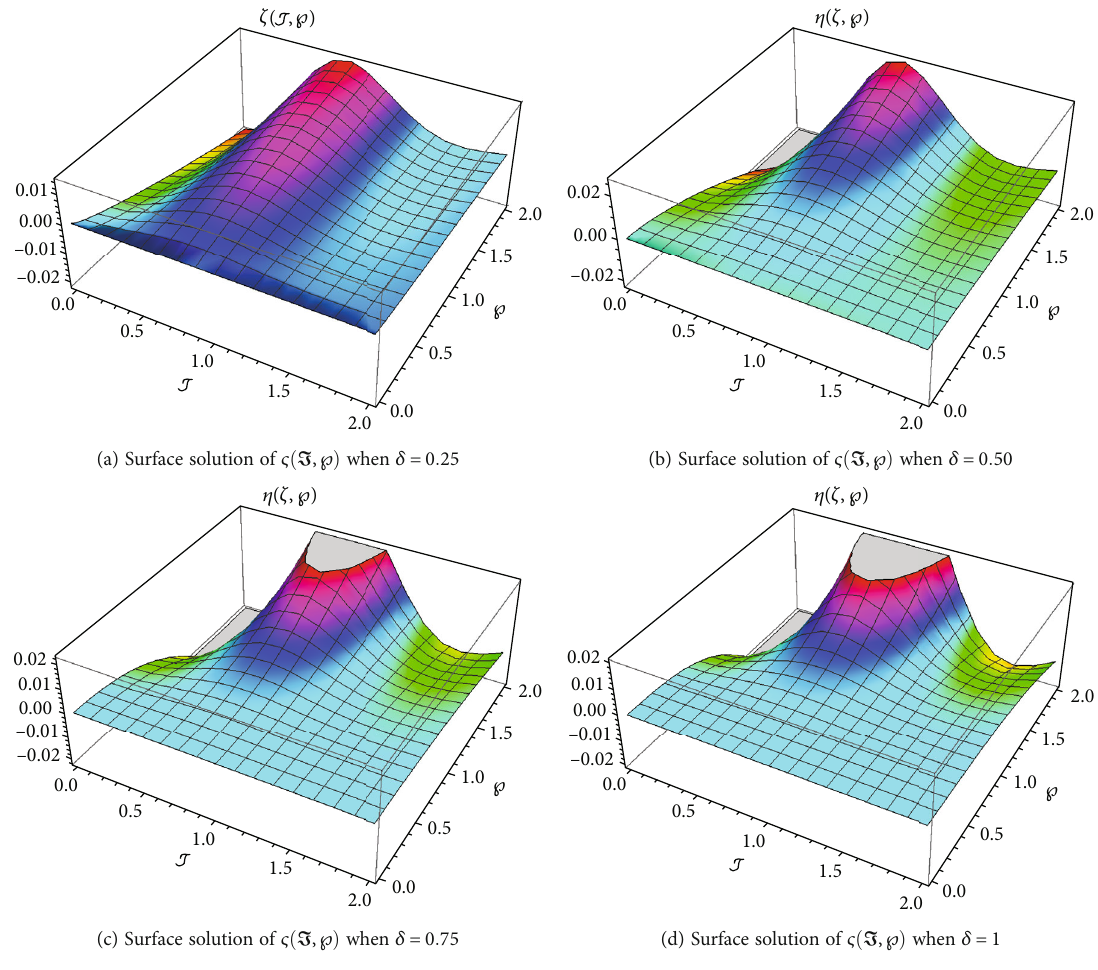
Figure 2: The surface solution of ς ð I , ℘ Þ for distinct values of δ